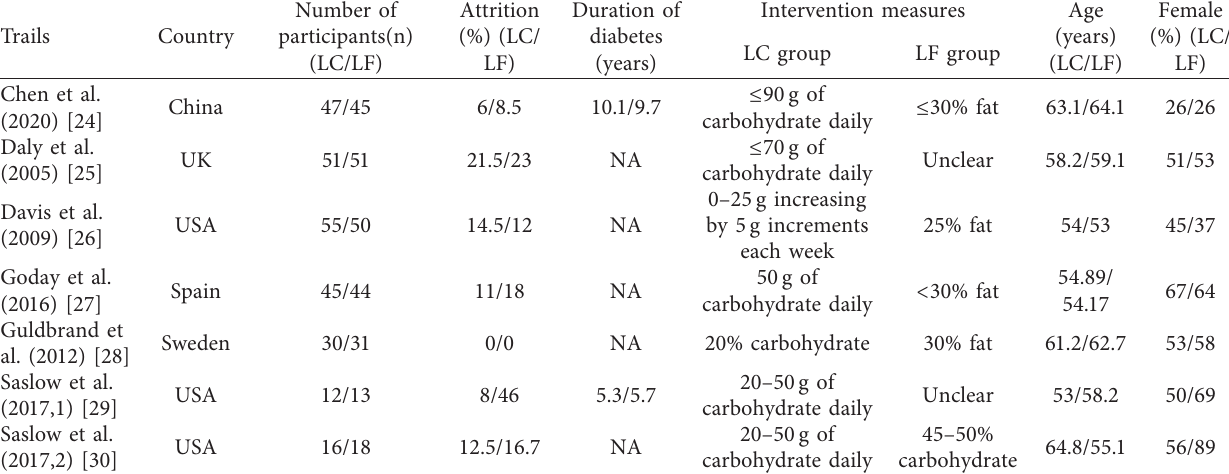
Figure 1: Flow diagram of study selection. Table 1: Characteristics of the trials and baseline of the enrolled